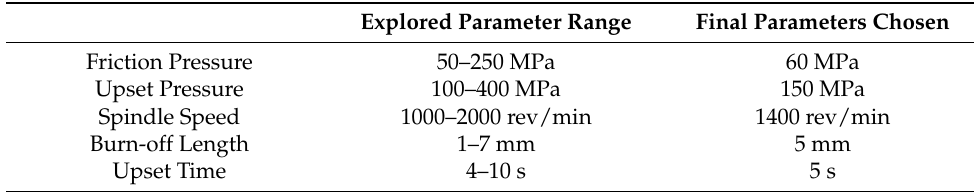
Table 2. Welding parameters.